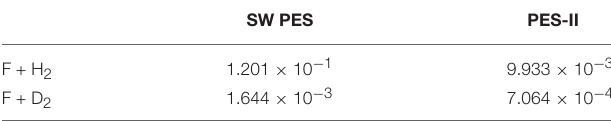
TABLE 2 | Values of the imaginary scattering length, β , in atomic H 2 and ···